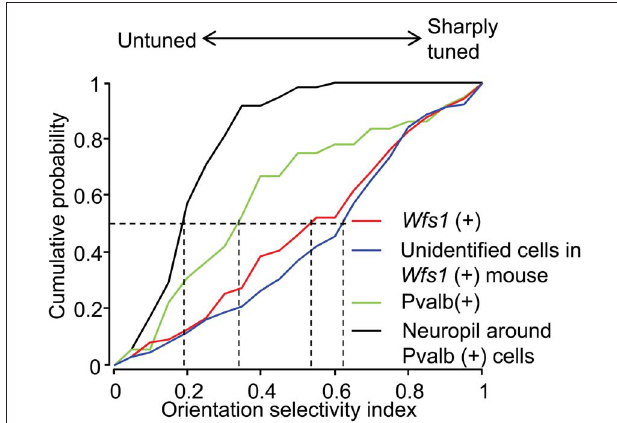
FiGure 4 | Comparison of orientation selectivity of Wfs1 (+) and Pvalb (+) cell population. Cumulative probability distribution of the orientation selectivity index (OSI) of Wfs1 ( + ) cells, unidentified cells, Pvalb ( + ) cells, and the neuropil near the Pvalb ( + ) cells is plotted. Dropped vertical dotted lines represent the median of each